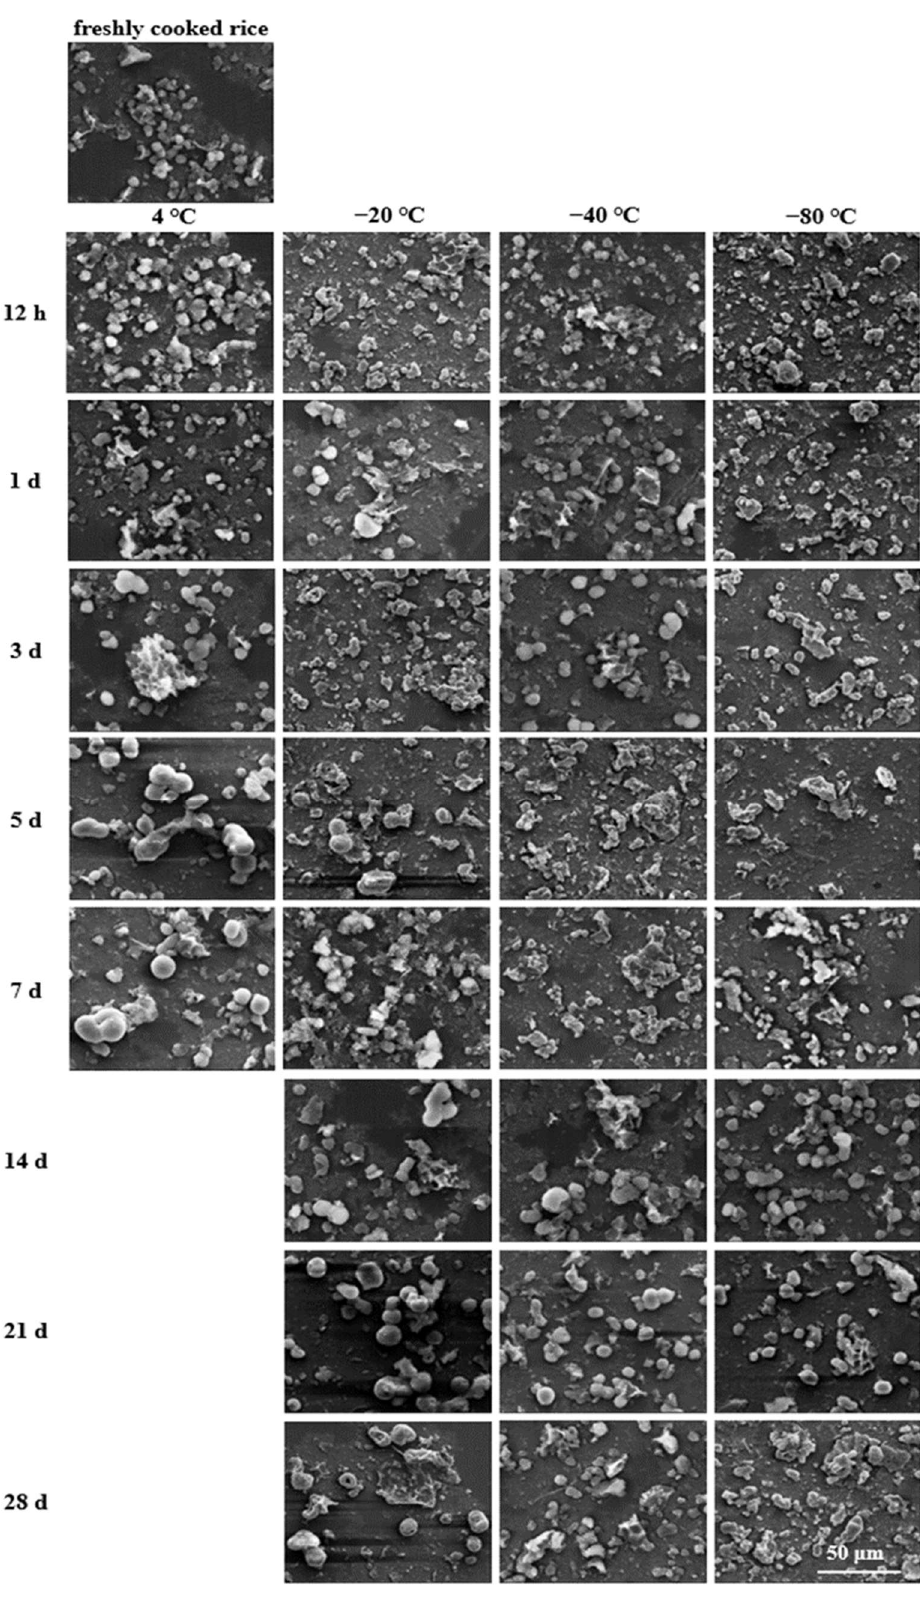
Figure 8. Microstructural changes of fresh and stored rice samples digested in simulated intestinal digestion for 180 min (2400×, bar = 50 μm).